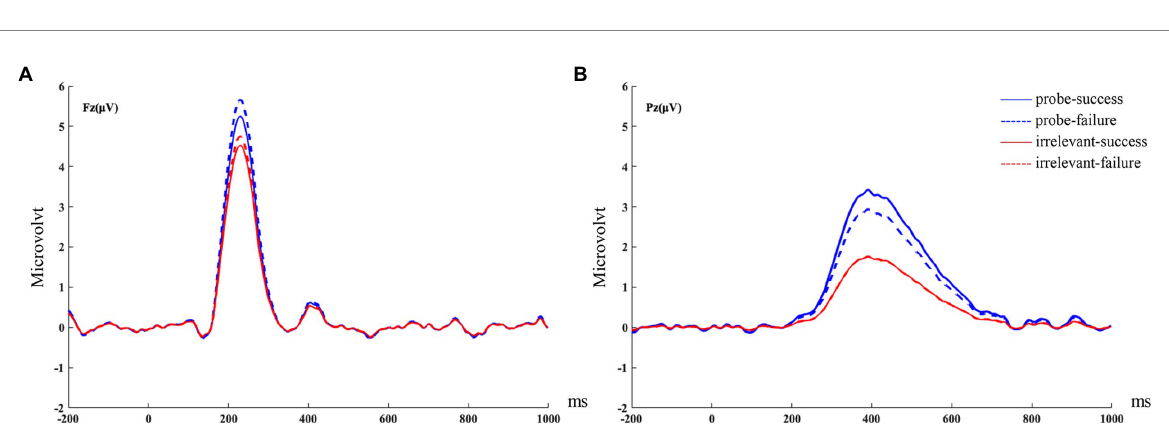
that the probe elicited a more positive feedback-P300 than did the irrelevants in the guilty group [6.25 ± 1.12 vs. 2.82 ± 1.02 μ V, t (23) = 5.75, p < 0.001, Cohen’s d = 0.52, BF 10 = 3.76 × 10 3 ]. But among the innocent group, there was no feedback-P300 difference between the probe and irrelevants [0.55 ± 1.03 vs. 0.86 ± 0. 94 μ V, t (27) = − 0.55, p > 0.05, Cohen’s d = 0.08, BF 01 = 4.20]. No other